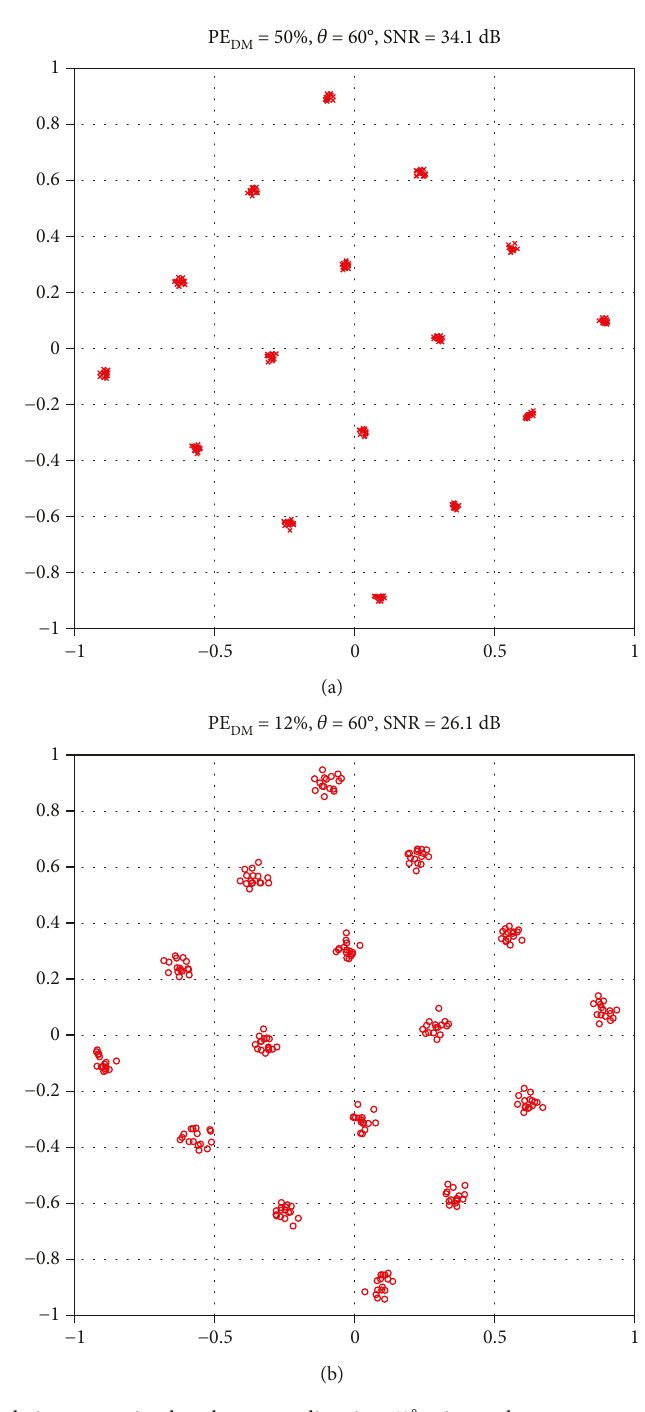
PE = 50% . (b) PE = 12% DM DM